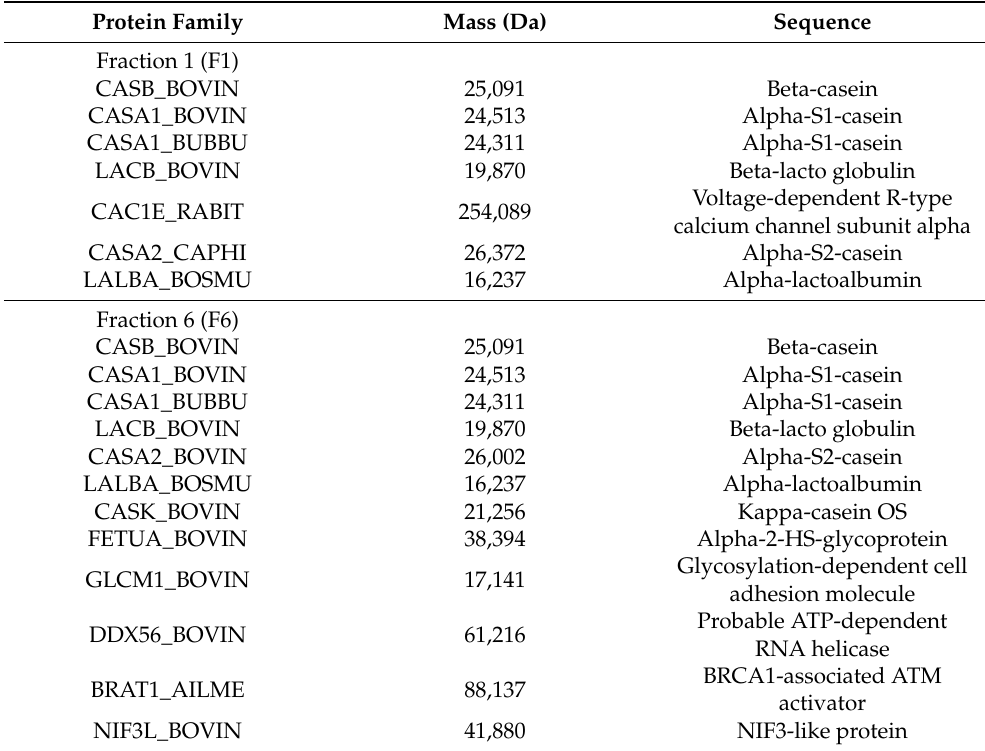
Table 2. Protein families of peptides identified in fraction 1 (F1) and 6